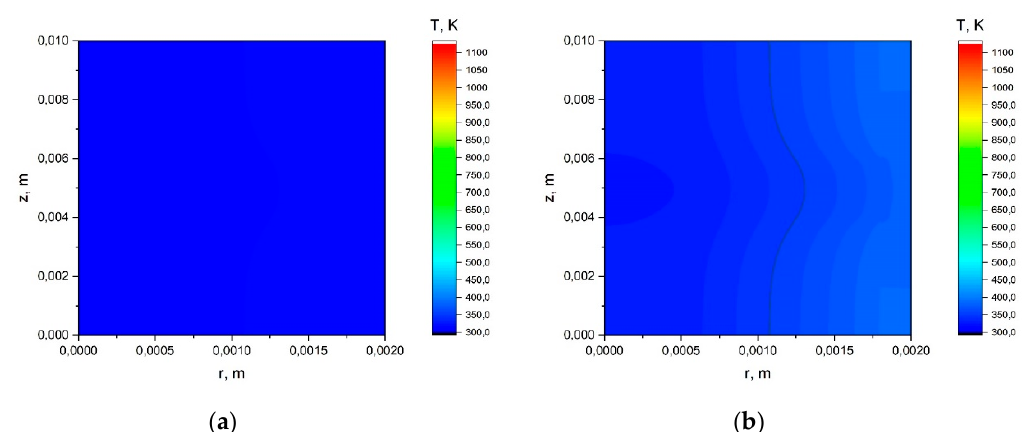
Figure A18. Temperature distribution in the stem of a herbaceous plant: R = 0.002 m, t = 6 s, q = 0.5 kW/m 2 ( a ); R = 0.002 m, t = 6 s, q = 3 kW/m 2 ( b ).